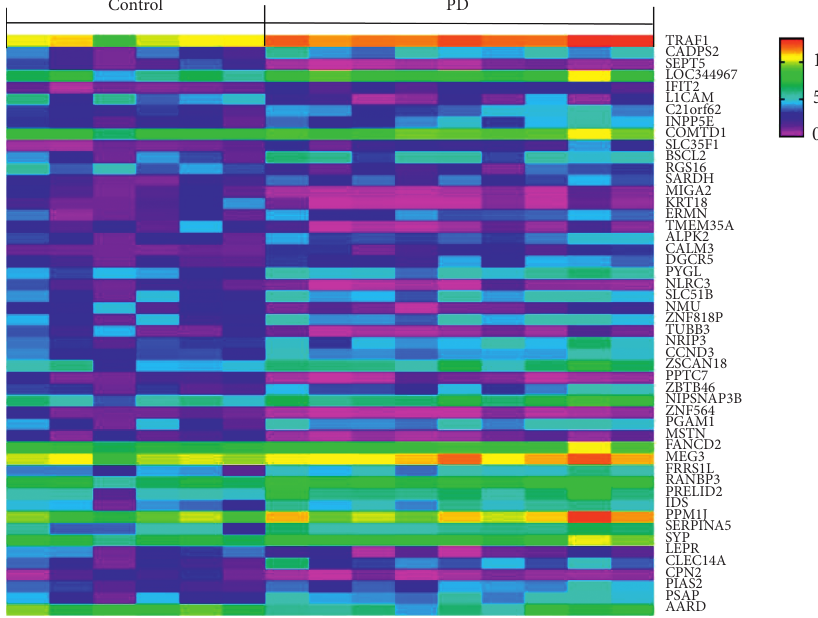
Figure 2: Heat map of the top 50